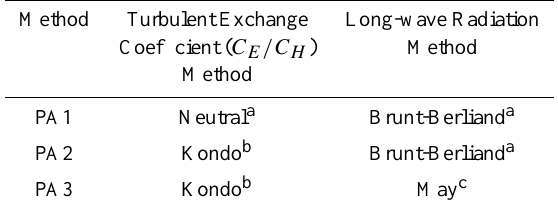
Table 3. The combinations of heat flux formulations used; (a) Rosati and Miyakoda (1998), (b) Kondo (1975) and (c) Budyko